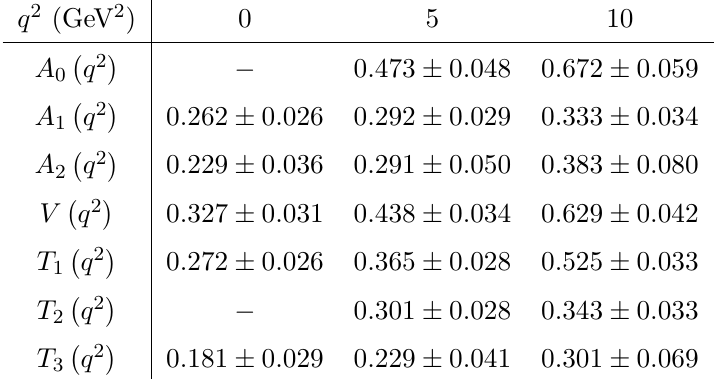
Table 3 . Synthetic datapoints for B → ρ transition form factors obtained in LCSR from the ref. [29], the corresponding correlations are given in eq. (A.2).